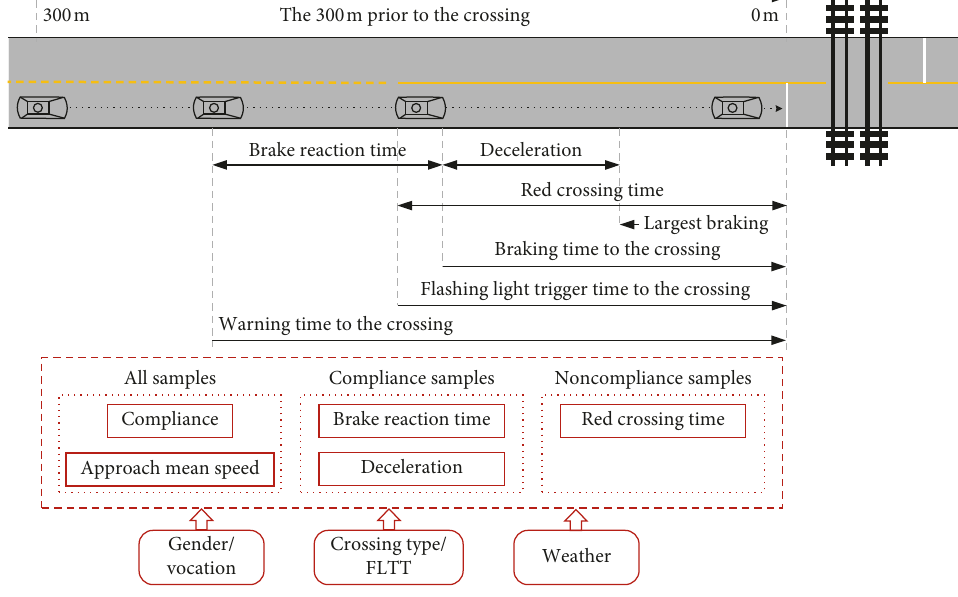
Figure 5: Dependent and independent variables in this study. Table 1: Basic description for compliance